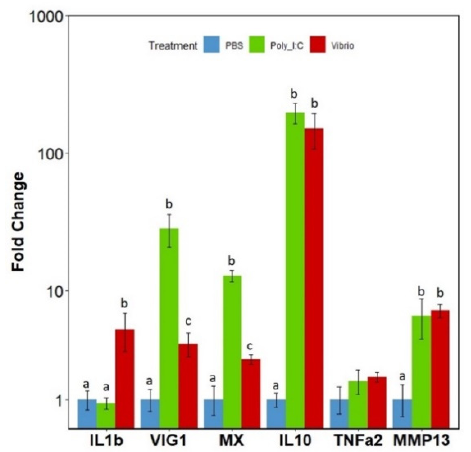
Figure 6. Fold change expression of inflammation marker genes: interleukin 1 β (IL1b), viperin (vig1/rsad2), interferon-induced GTP-binding protein 3 (mx3), interleukin 10 (il10) and matrix metalloproteinase 13 (mmp13) in spleen tissue of rainbow trout. Fish were injected i.p. with either PBS, V. anguillarum extract or poly I:C for 24 h. Expression was normalised to the housekeeping gene β actin. A linear model was used for analysis of all genes. Bars represent fold change relative to the PBS control group ( ± SEM), n = 4. Results of the Tukey post hoc test are displayed above the bars. Bars which do not share a letter are significantly different.